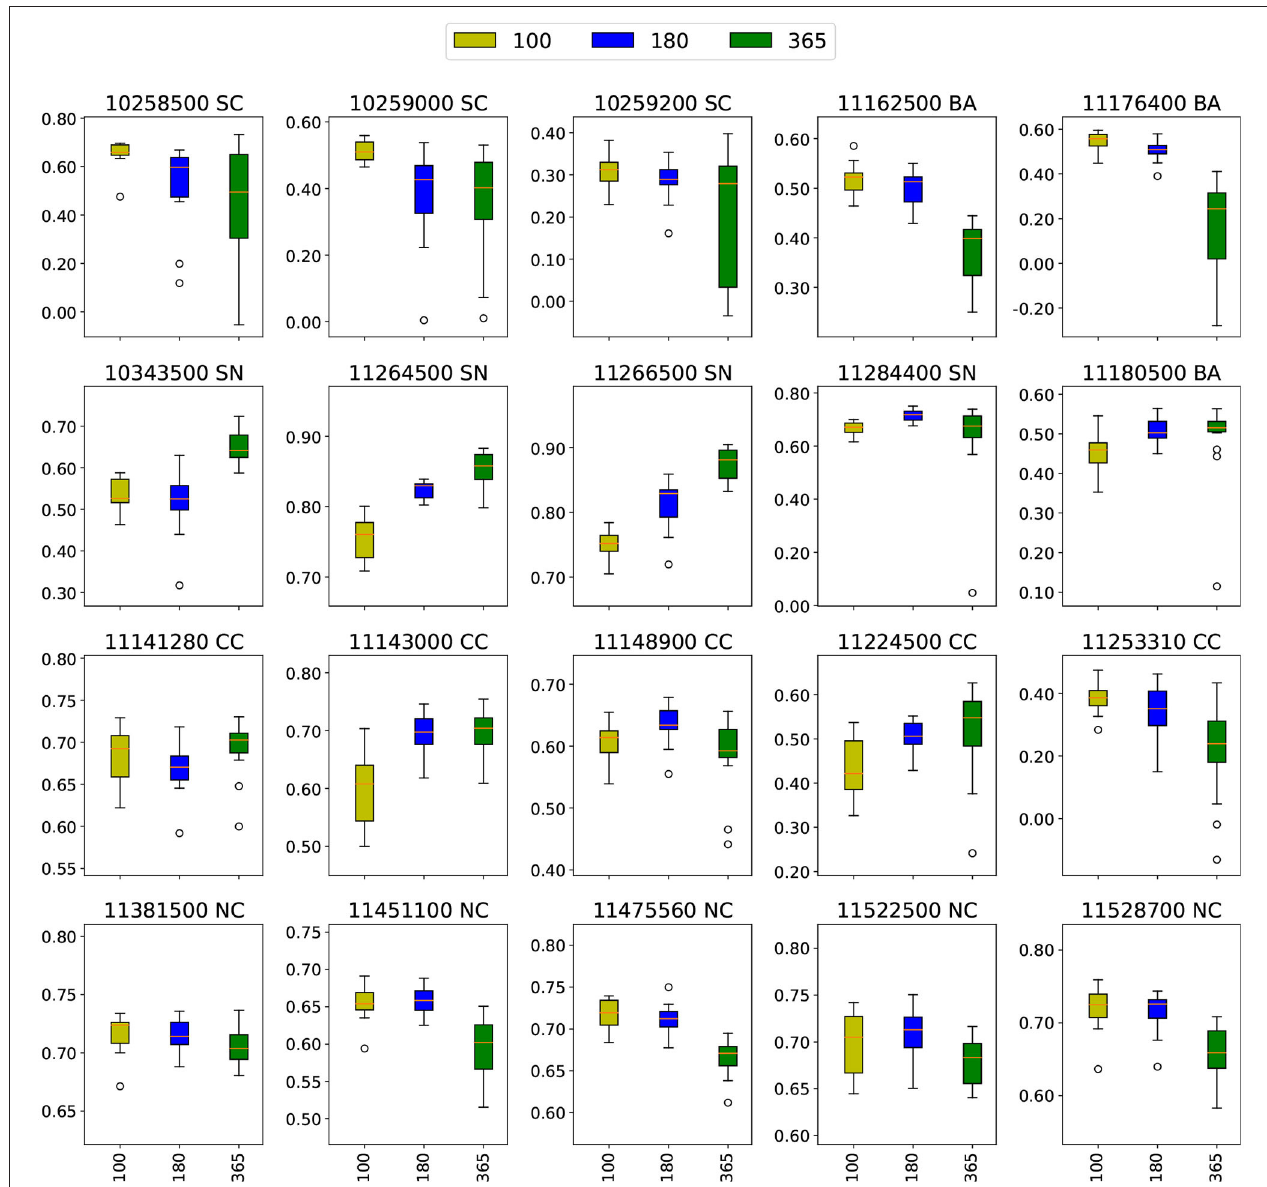
FIGURE 5 | Ensemble prediction comparison for all basins with different window